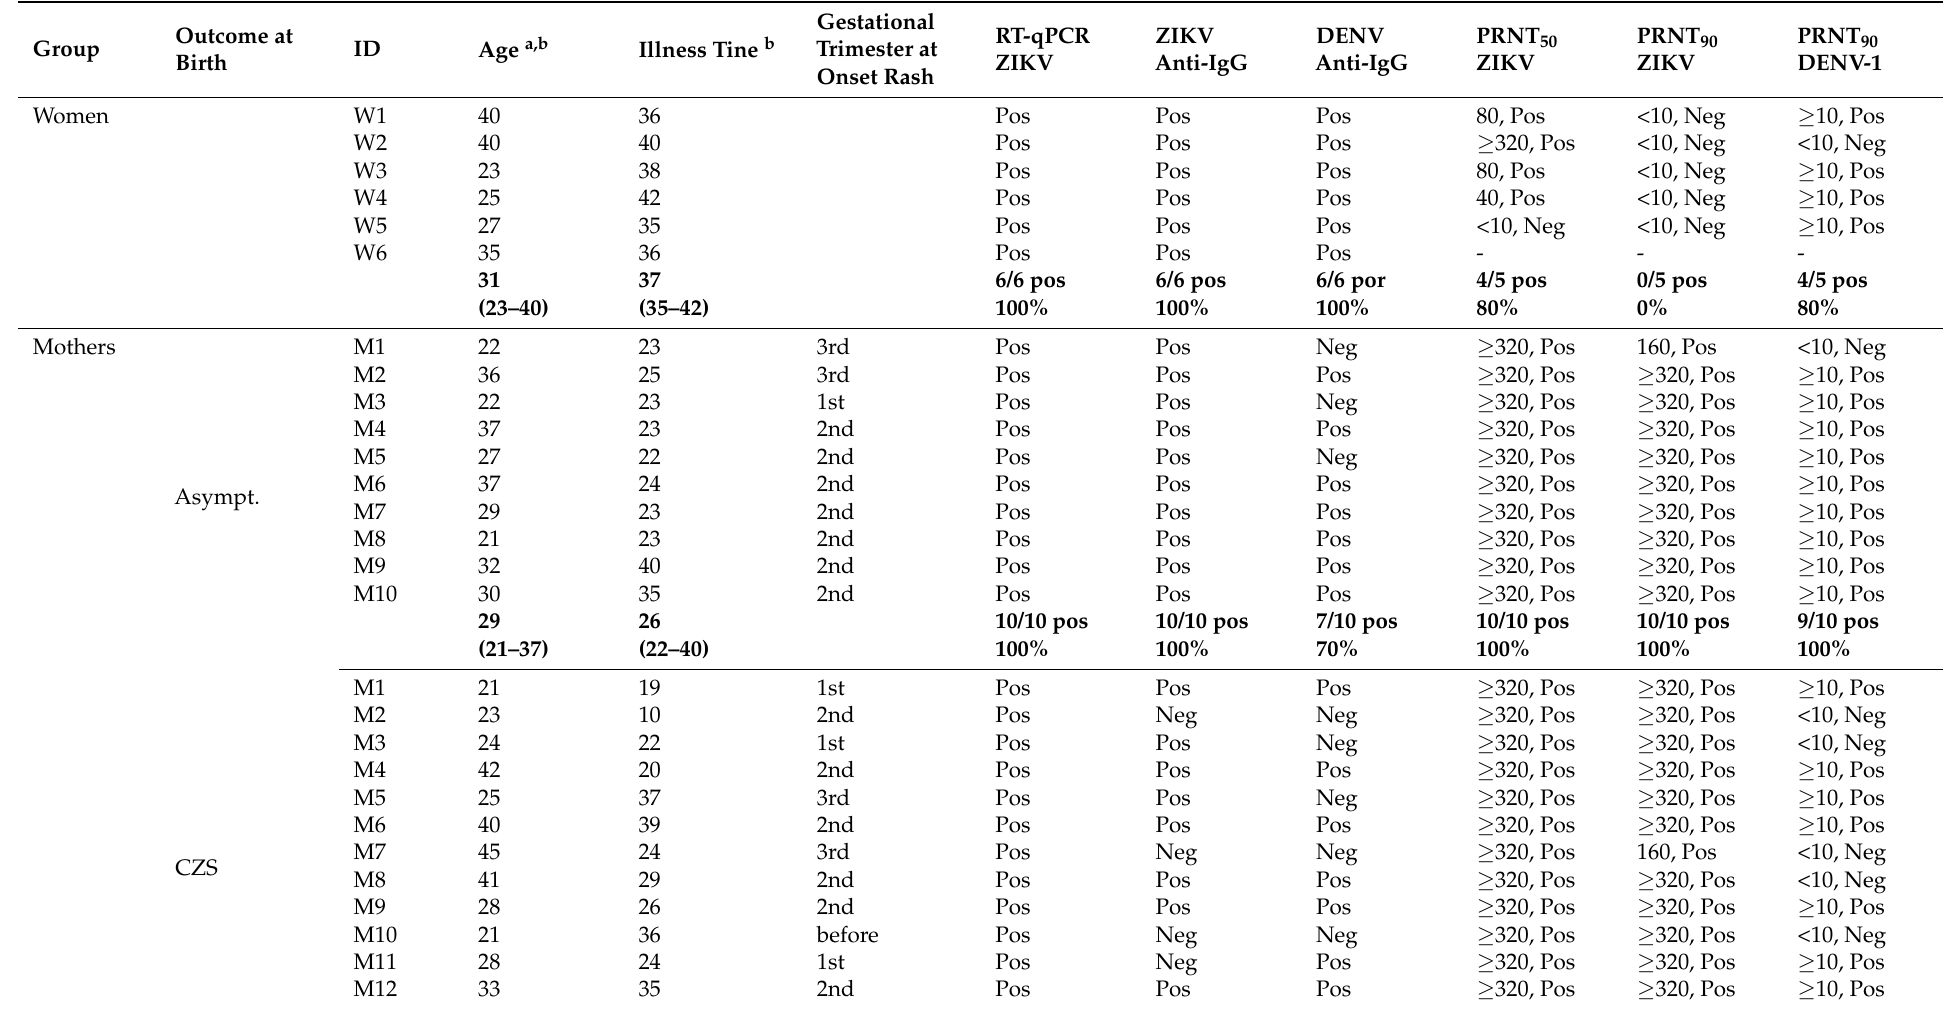
Table 1. Characteristics of the recovered mothers infected with Zika virus during pregnancy and their intrauterine exposed children recruited from 2018 to 2019.